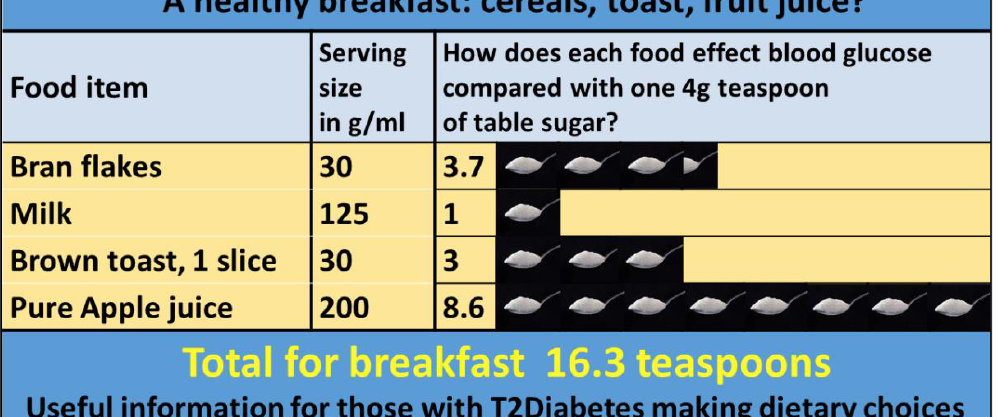
Figure 2. A NICE (National Institute of Clinical Excellence) endorsed infographic based on glycaemic load data, created by author D.U. showing the possible glycaemic consequence of a meal. Authors (T.K., F.F., D.U.) find these infographics extremely useful when explaining to patients the